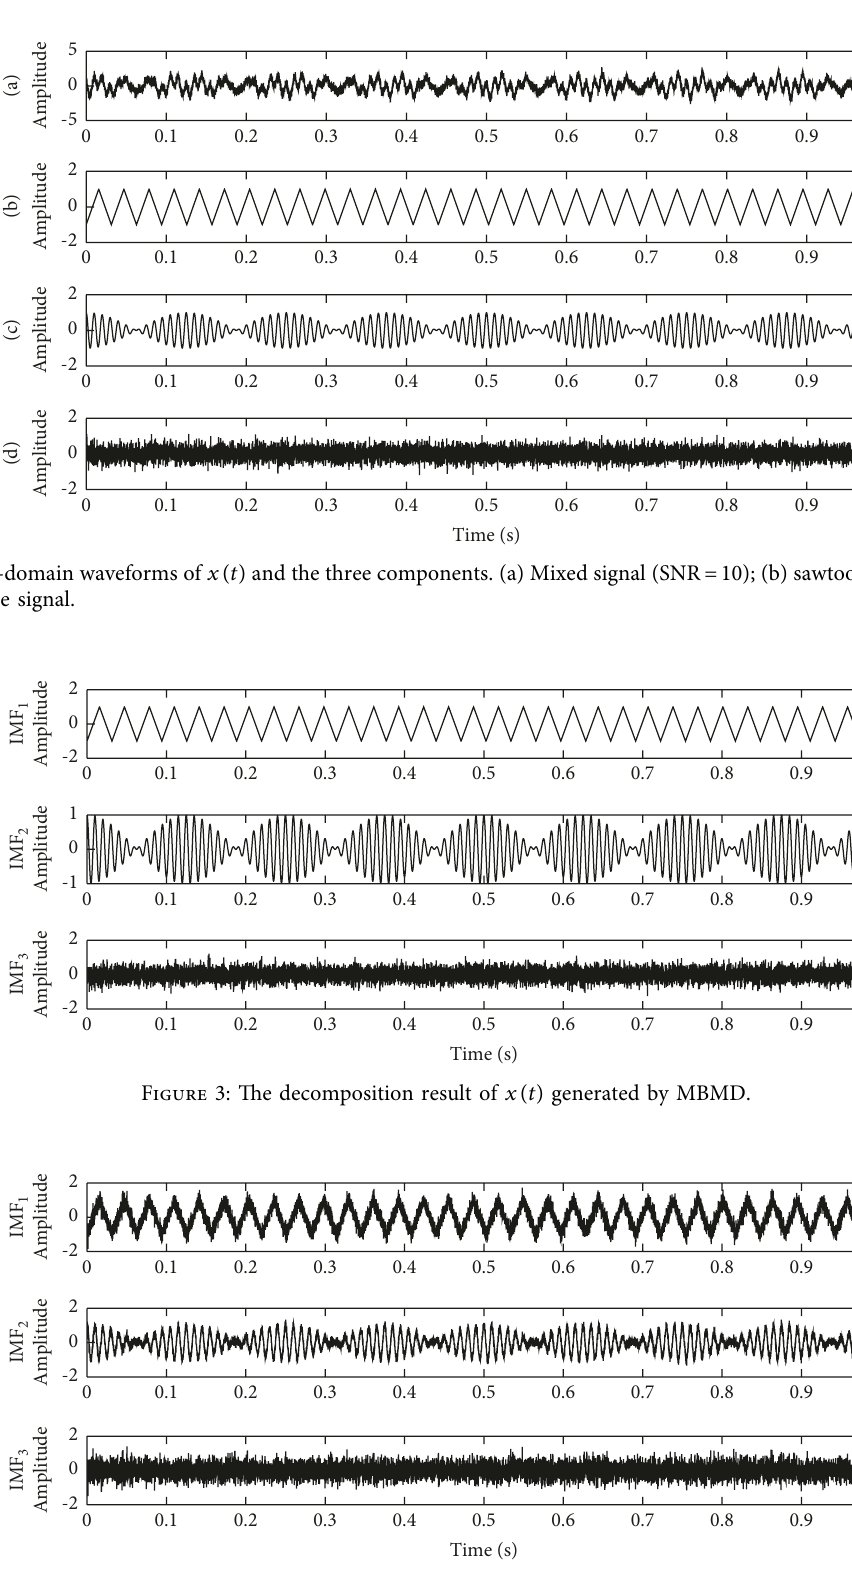
Figure 4: The decomposition result of x ( t ) generated by BMD.